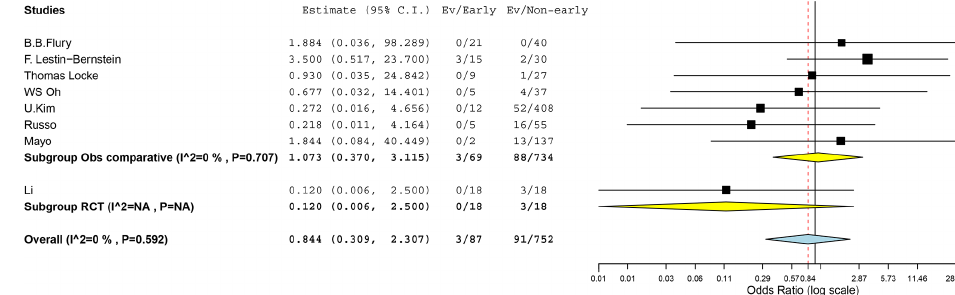
Figure 2. Meta-analysis of risk for failure and relapse between early switch and non-early switch to oral therapy for bacterial NVO (CI, confidence interval; Obs, observational, RCT, randomized clinical trial, Ev, events).